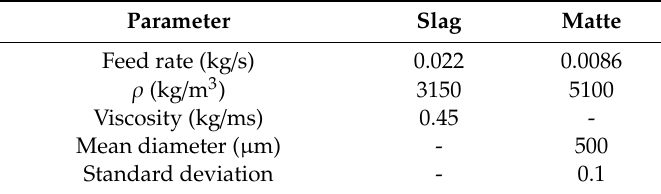
Table 2. Size distribution of the droplets at the inlet.